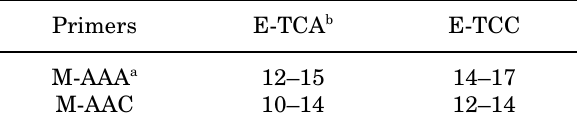
Table 2. Number of polymorphic markers generated per primer pair combination in Fusarium oxysporum f. sp.